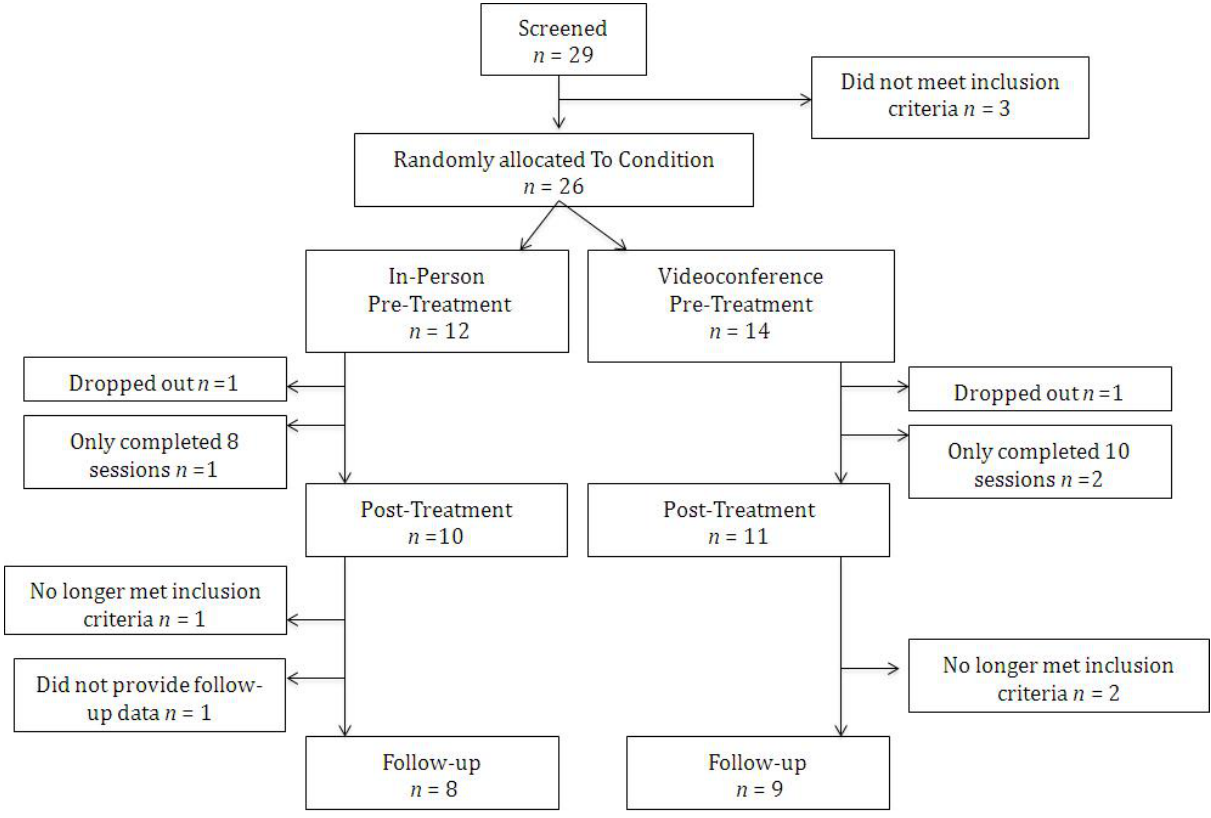
Figure 1. The number of participants and their flow throughout the